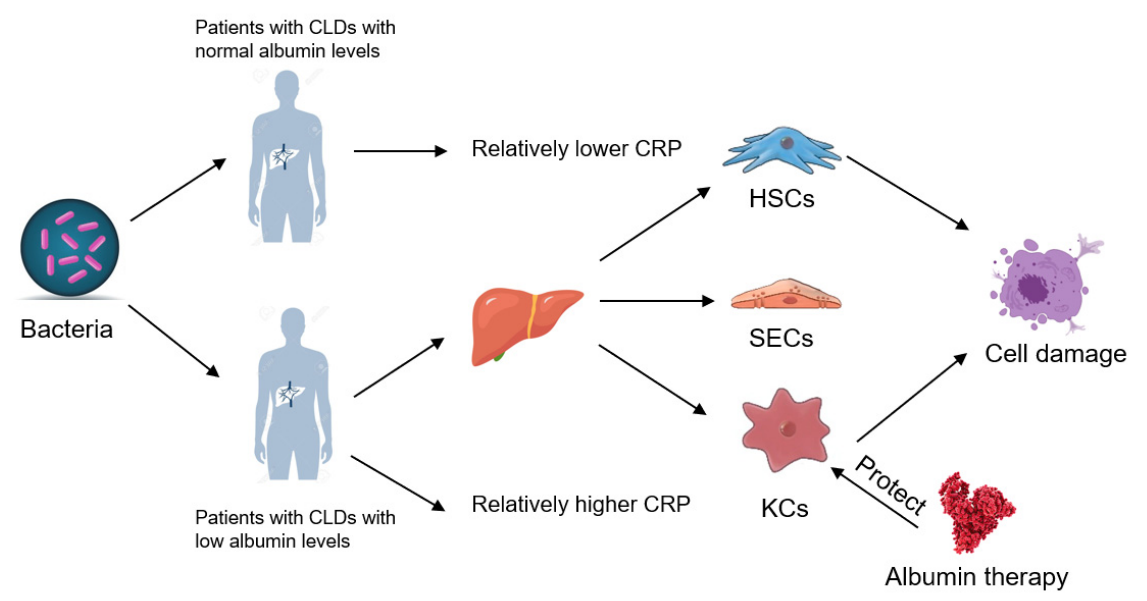
Figure 5. A proposed role of albumin in patients with CLDs and different hepatic non-parenchymal cells. Bacteria raised higher CRP levels in patients with CLDs with low albumin than CLD patients with high albumin. HSCs and SECs instead of SECs could be demolished by bac- teria. However, albumin could protect KCs rather than HSCs from the cell damage caused by